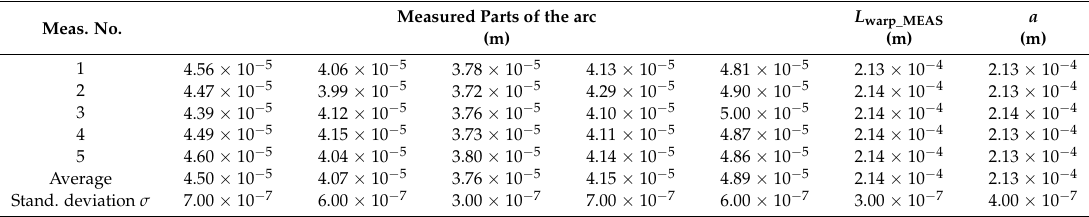
Figure 13. Measurement of the length of the warp for the sample RSKCu+Ni. Table 11. The measurement results of the length of the warp L WARP_MEAS and the length of the line connecting the arcs in warp a